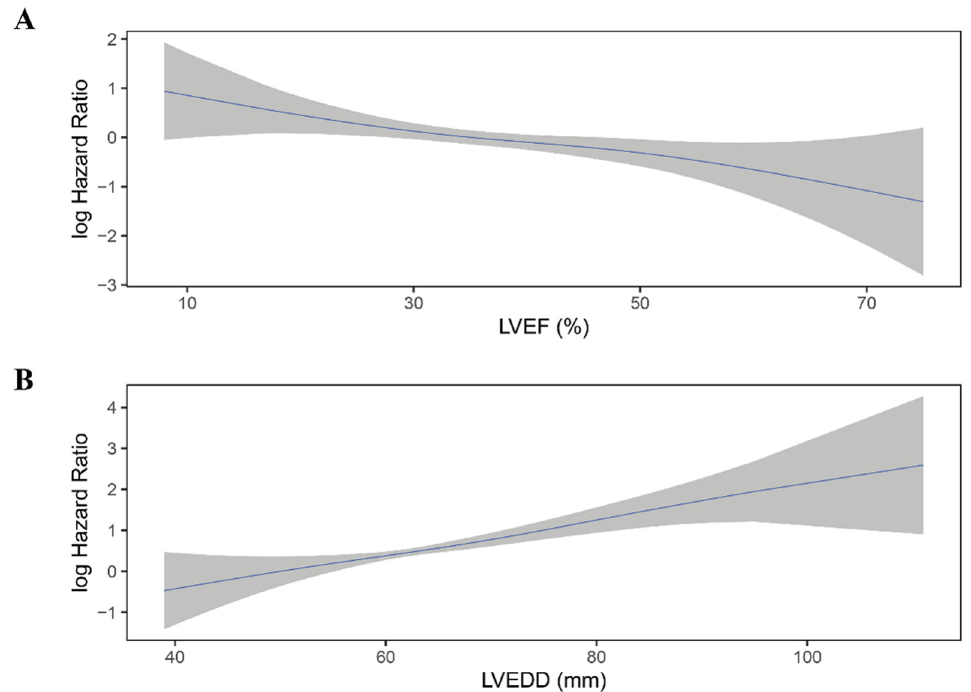
Figure 4. Continuous log HR plot for the relationship between echocardiographic parameters and all-cause mortality (( A ) LVEF; ( B ) LVEDD). Blue line: log HR; grey area: 95%CI. LVEDD, left ventricular end-diastolic diameter; LVEF, left ventricular ejection fraction.